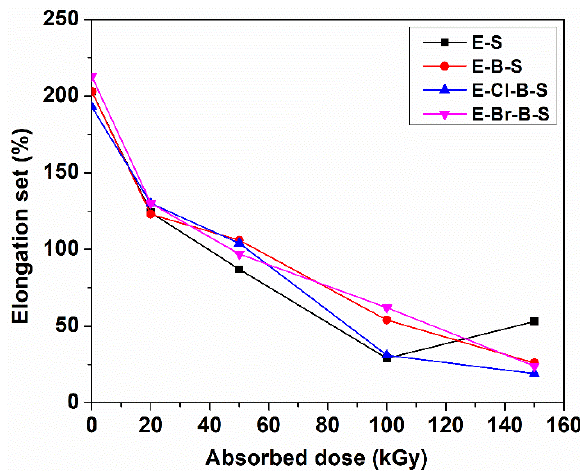
Figure 3. Elongation set at different electron beam irradiation dose.